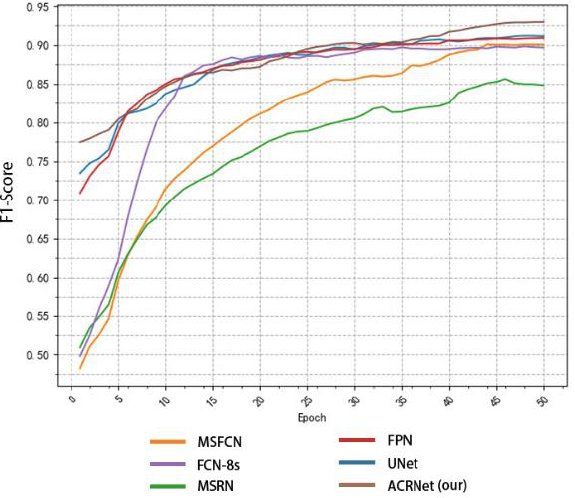
Figure 9. Variation of the recall of each model with the number of training epoch.